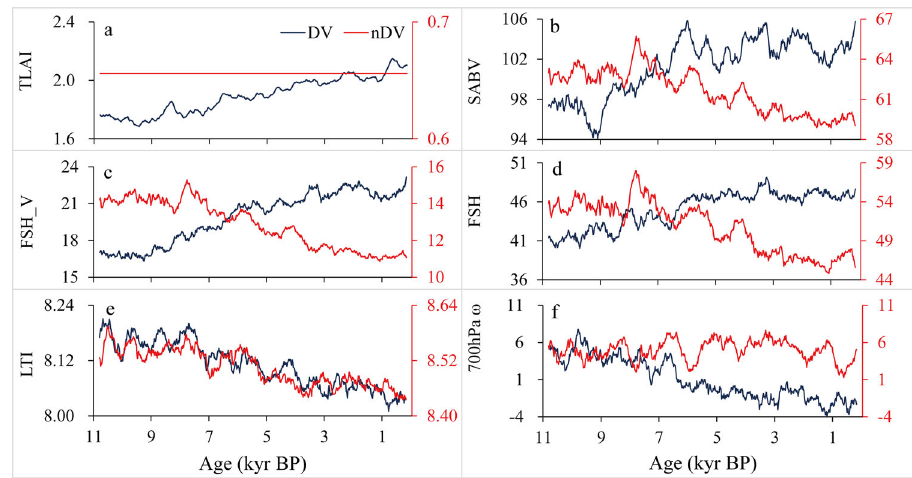
Fig. 5 Time series derived variables from DV and nDV runs during the Holocene in northern China. a Total projected leaf area index (TLAI); b Solar radiation absorbed by vegetation (SABV in W/m 2 ); c Sensible heat fl ux caused by vegetation (FSH_V in W/m 2 ); d Surface heat fl ux (FSH in W/m 2 ), e The 1000 – 850 hPa temperature difference representing low tropospheric instability (LTI in K); f The 700 hPa vertical rise rate ( ω in − 0.001 Pa/s). The blue line corresponds to the left Y -axis, and the red line corresponds to the right Y